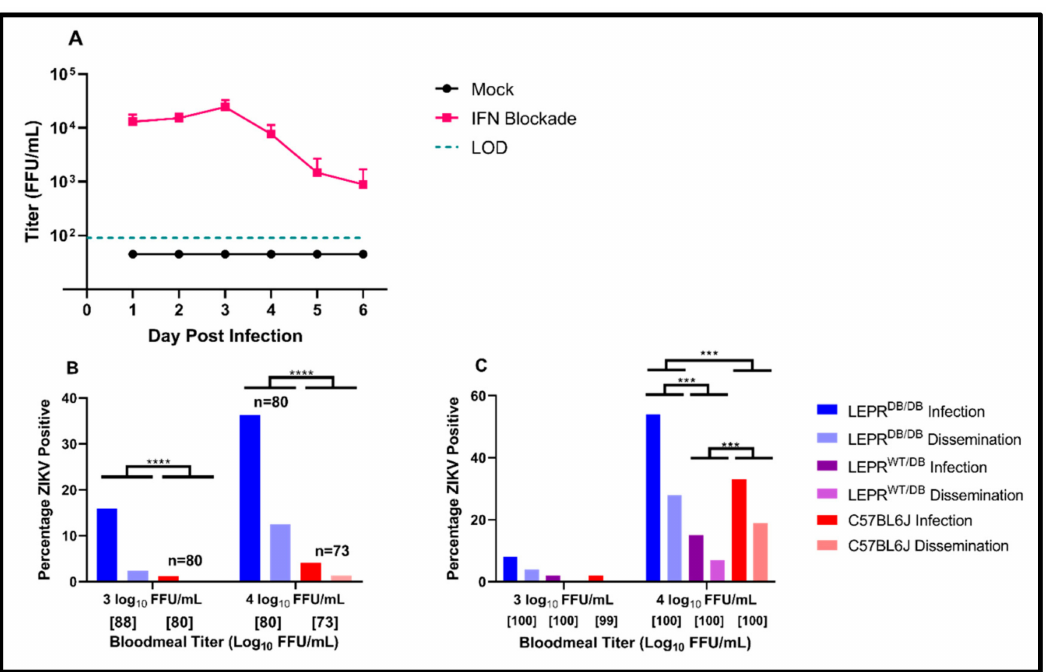
Figure 3. Susceptibility to ZIKV ingested from LEPR DB/DB and control animals. ( A ) LEPR DB/DB were treated with 1.5–1.8 mg of IFNAR-blockading antibody MAR1-5A3 one day prior to and one day after infection with 5.00 log 10 FFU of ZIKV PRVABC59. Viremia was determined via focus-forming assay performed on serum from retro-orbitally sampled blood. ( B ) ZIKV PRVABC59 was provided to Ae. aegypti (Galveston F5) via infected mice (either LEPR DB/DB or C57BL/6J). Mosquitoes were exposed to titers of 4.42 ± 4.02 log 10 FFU/mL (corresponding to 3 DPI) and 3.56 ± 2.95 log 10 FFU/mL (4 DPI). Blood-fed mosquitoes were incubated at 27 ± 1 ◦ C with 80 ± 10% relative humidity